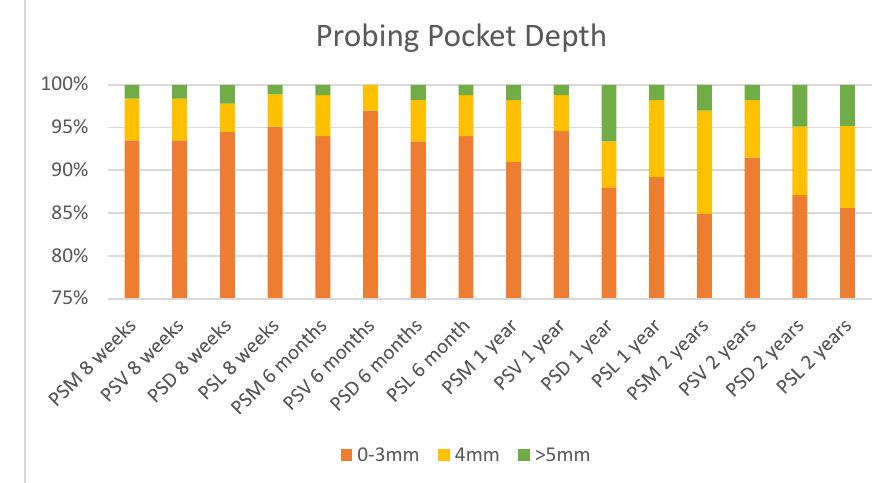
Figure 4. Probing pocket depth.